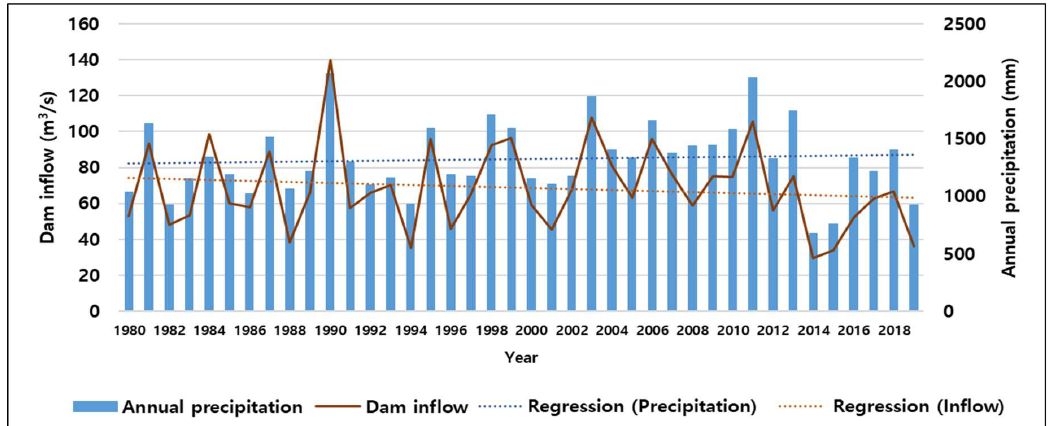
Figure 2. Annual precipitation and mean annual dam inflow during 1980–2019 of Soyang River Dam.